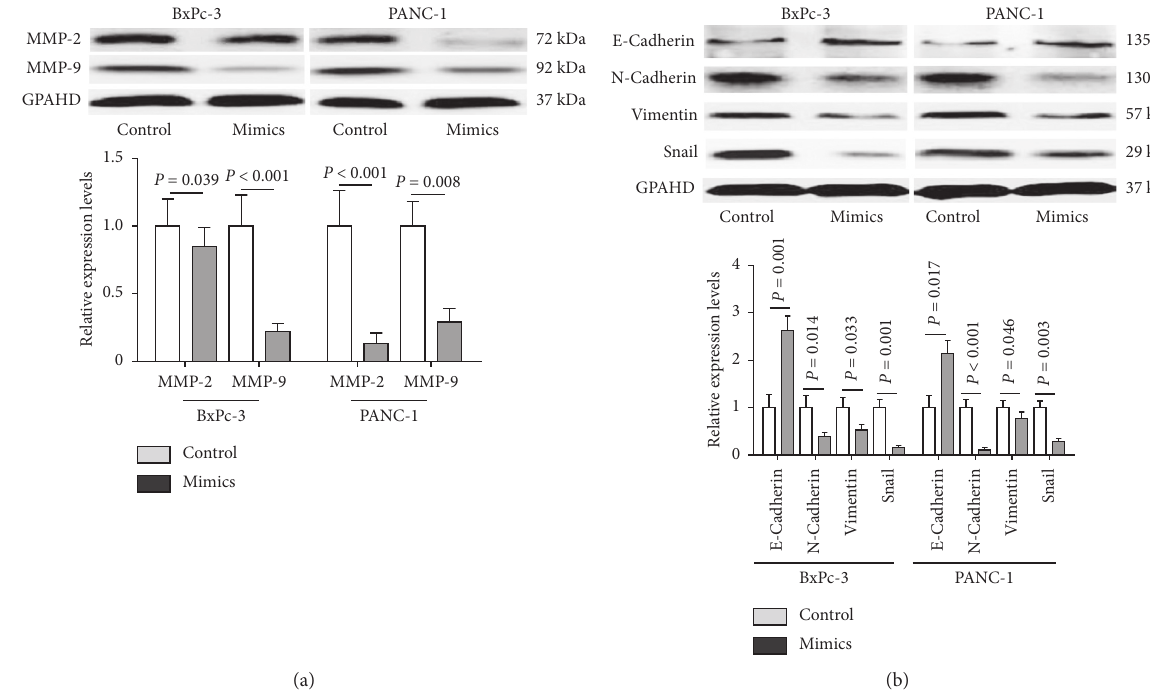
Figure 5: The impact of miR-607 on the EMTability of PDAC cells. (a) Western blotting analysis assay confirmed the reduced expression of MMP-2 and MMP-9 (normalized to GAPDH) after miR-607 was overexpressed in BxPc-3 and PANC-1 cells. (b) Relative protein expression levels of EMT-related genes in PDAC cells after miR-607 overexpression were determined. Data were representative of at least three separate